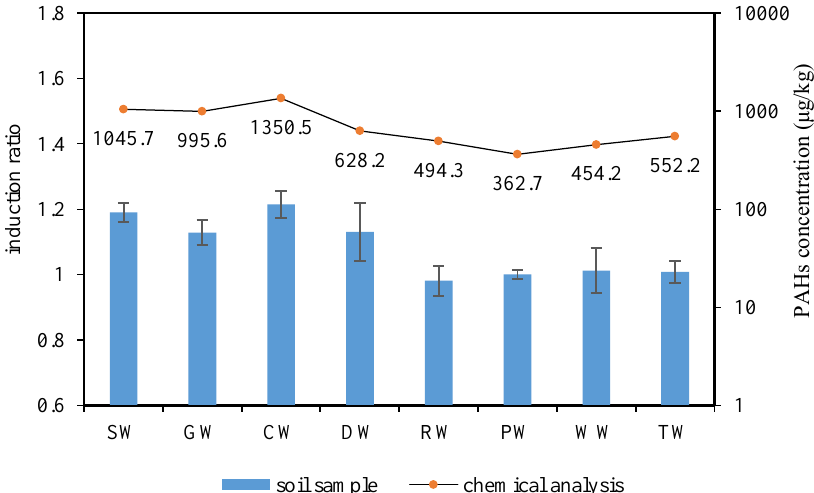
Figure 6. Comparison of genotoxicity (column) and chemical analysis (dots) of soil samples. Error bars indicate standard deviations of the replicates.